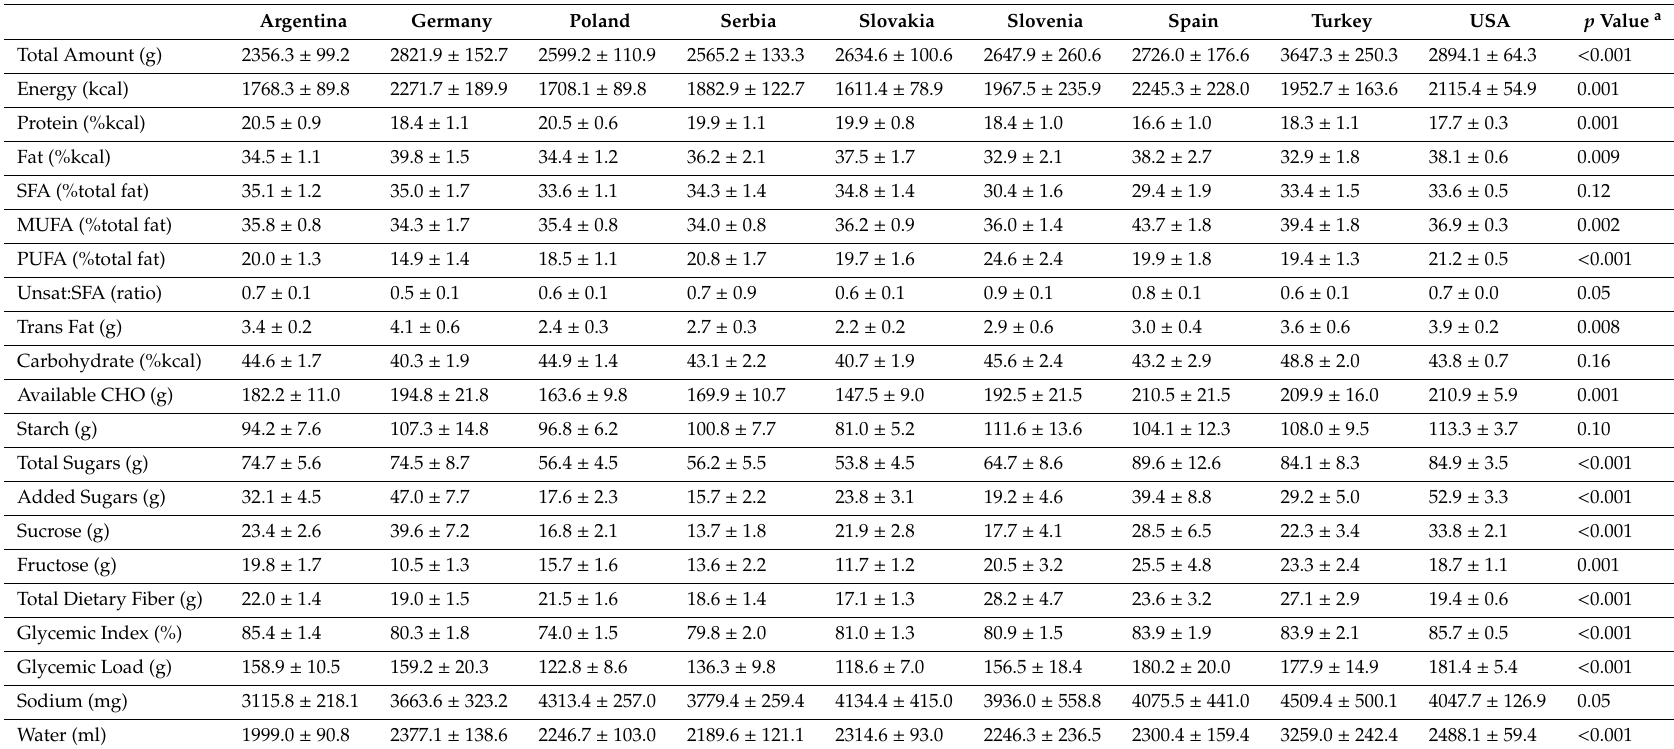
Table 1. Energy and Nutrient Intakes by